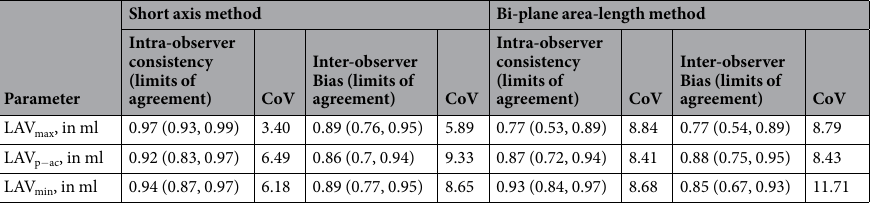
Table 10. Inter- and intra-variability in left atrial volumes (n = 135) LAV max , maximal left atrial volume; LAV p − ac , left atrial volume before atrial contraction; LAV min , minimal left atrial volume.